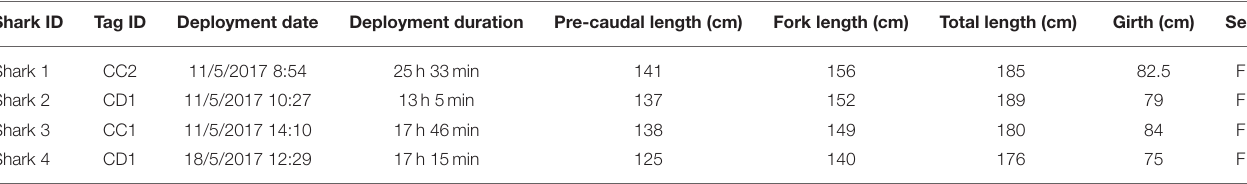
TABLE 2 | Summary details of tagged sandbar